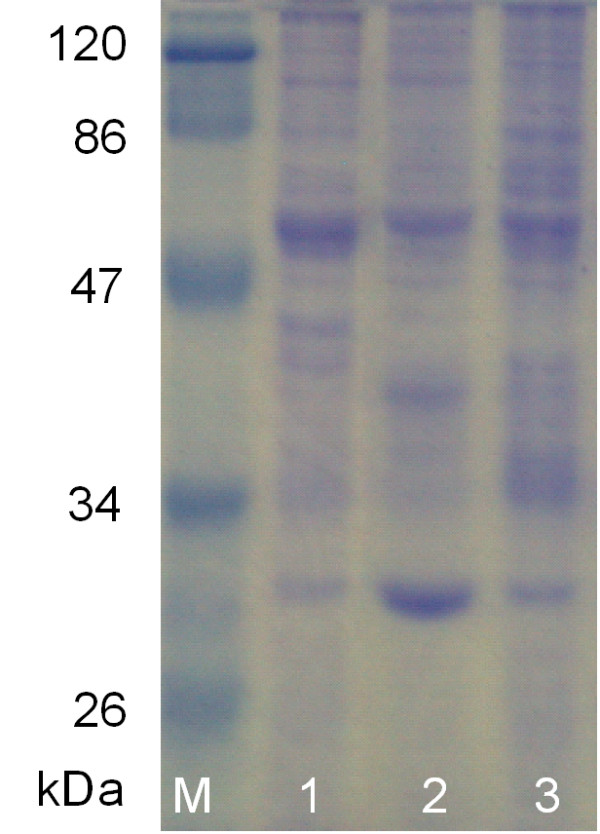
Protein pattern of Geobacillus zalihae T1T and its phylogenetic neighbors. M: Marker; 1: DSM 5366T; 2: DSM 7263T; 3: T1T.